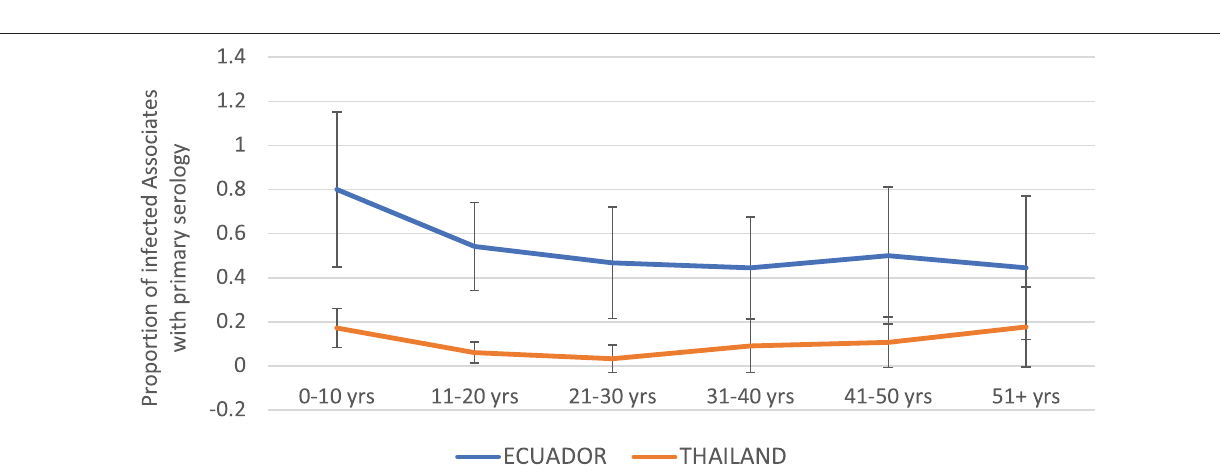
FIGURE 4 | Proportion of DENV-infected Associates found to have primary DENV infection (by ELISA), by age and study site. Thailand is shown in orange and Ecuador in blue. Error bars reflect the 95% confidence intervals for the proportions.